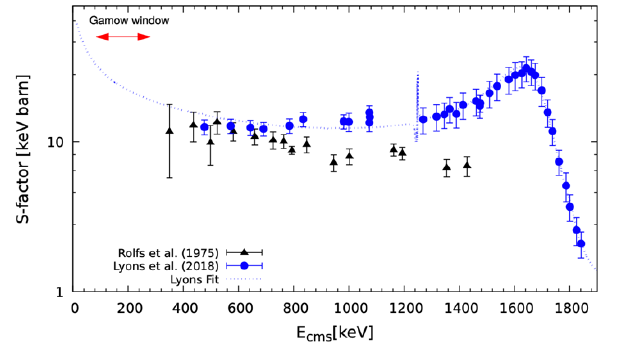
Fig. 2. Literature data for the astrophysical factor of the DC à 2425 keV transition [10-11].